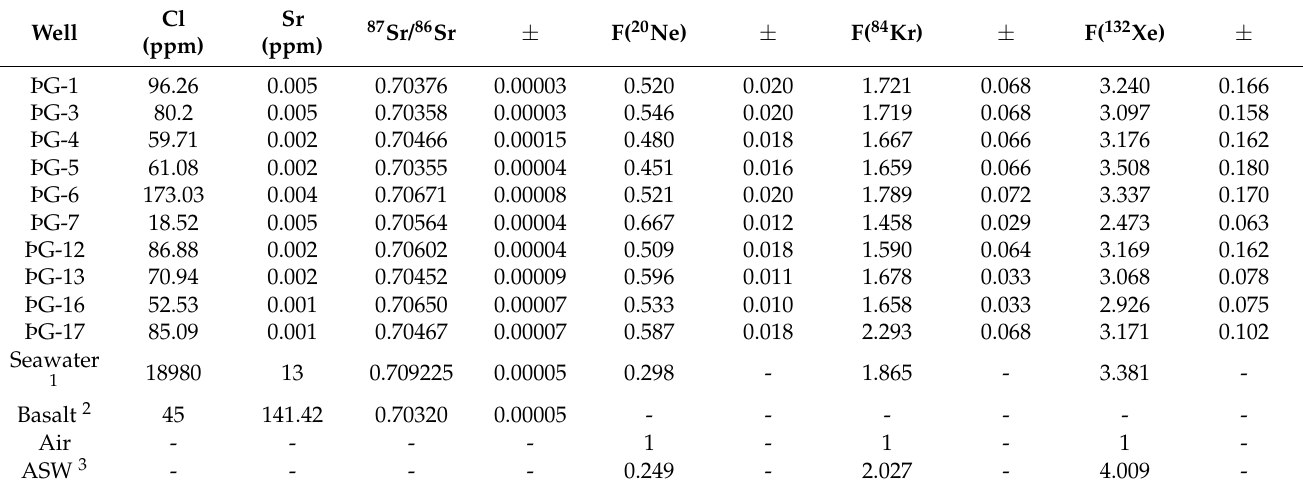
Table 1. Cl, Sr, 87 Sr/ 86 Sr and ANG F-values for Theistareykir geothermal fluids and fluid endmem-